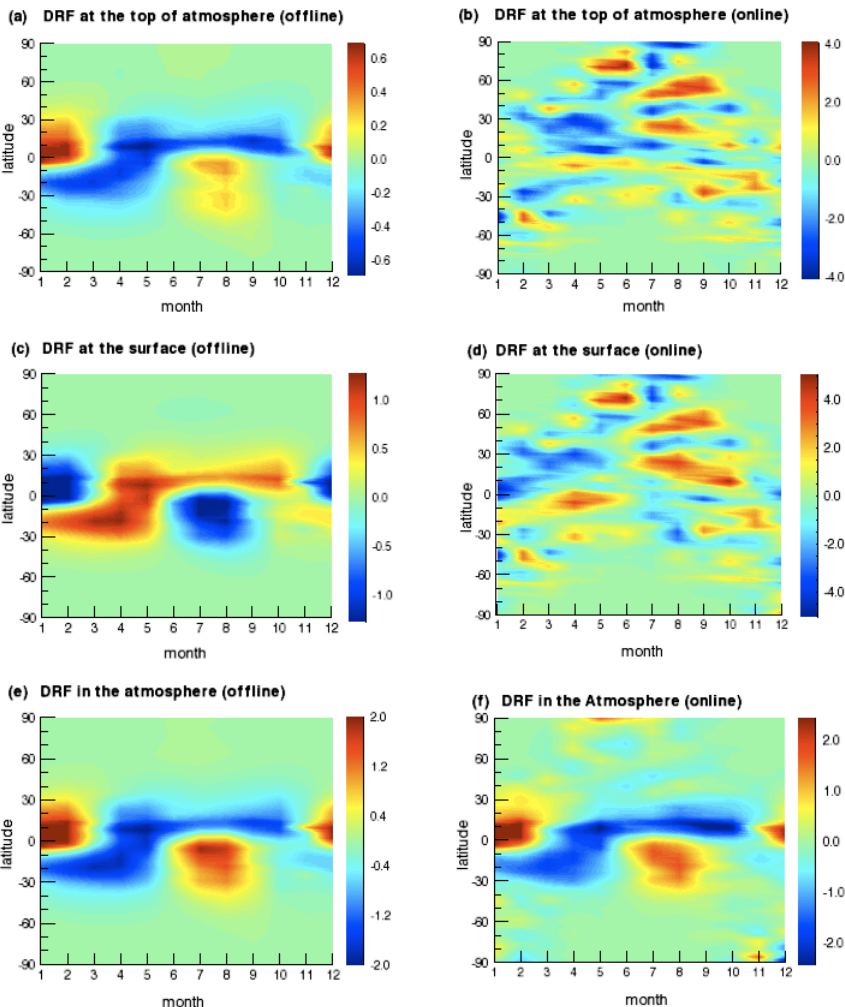
Fig. 7. Hovm¨oller diagrams of zonal and monthly means of differences in DRF (W/m 2 ): (a) and (b) at the top of the atmosphere, (c) and (d) at the surface, (e) and (f) in the atmosphere due to seasonal BBCA emissions, here (a), (c), and (e) are offline results and (b), (d), and (f) are online